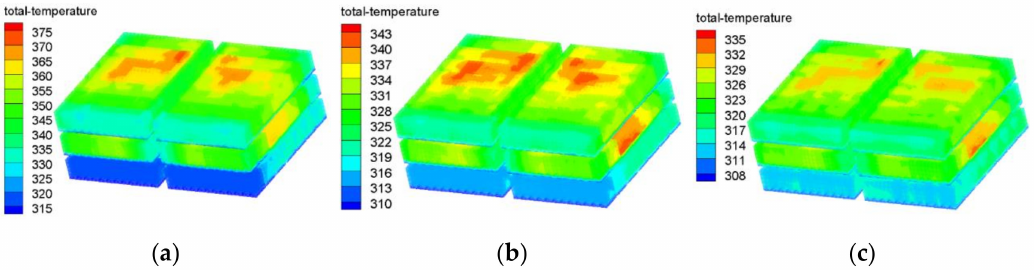
Figure 8. Temperature cloud diagrams for type II battery pack under different inlet wind speeds: